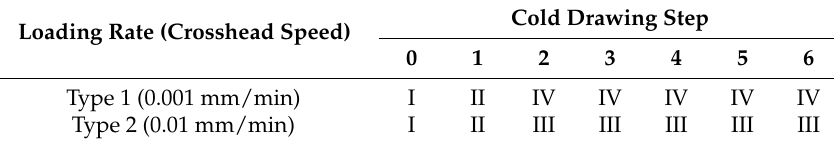
Table 1. Models of MFM for each loading rate (crosshead speed) and drawing degree. Loading Rate (Crosshead Speed)